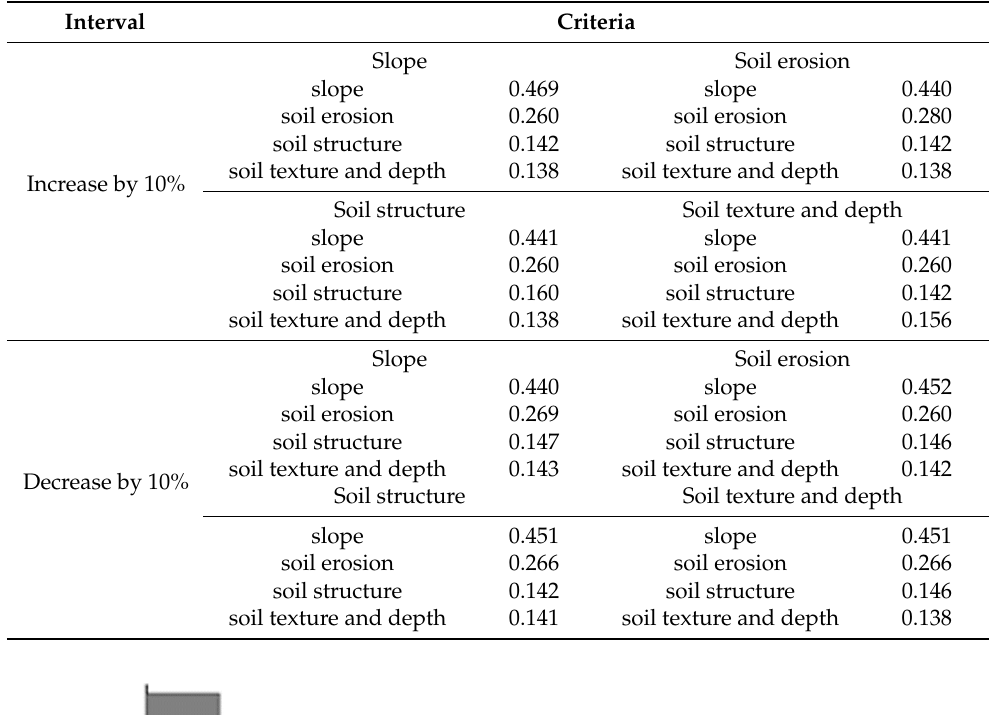
Table 5. Sensitivity analysis to check criteria validity using a ± 10% interval.